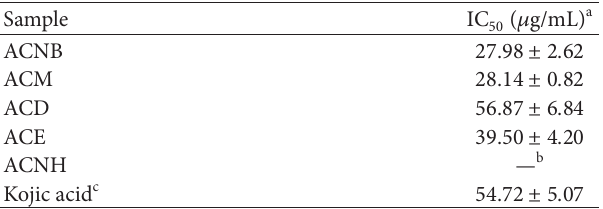
Table 2: The cell-free tyrosinase inhibitory activity of Artocarpus communis methanolic extract and its different fractions.